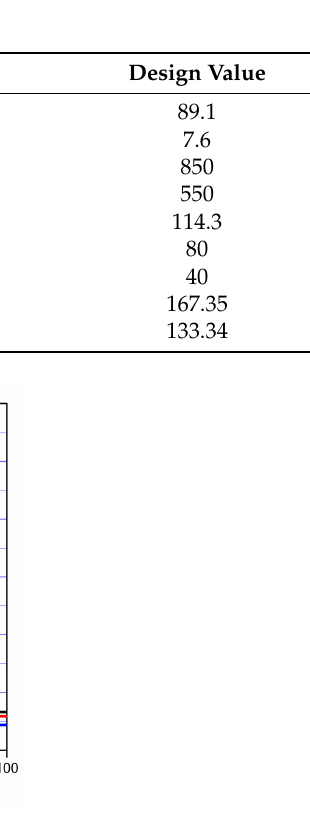
Figure 2. Target required response spectrum corresponding to PGA = 0.3